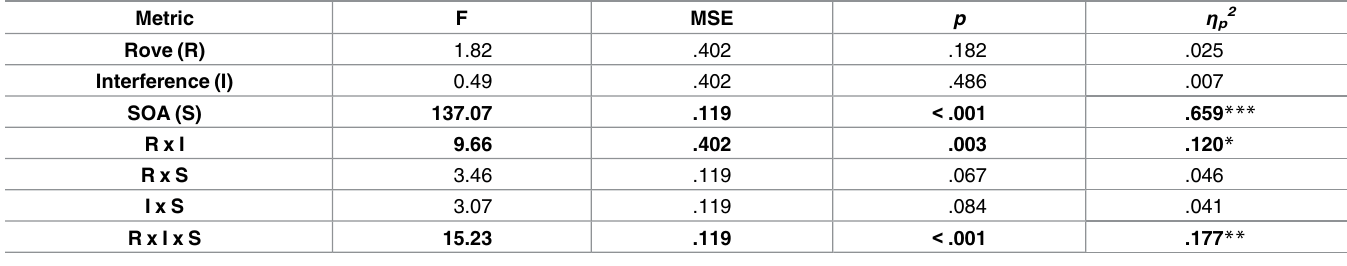
Statistical significance indicated by bold text.